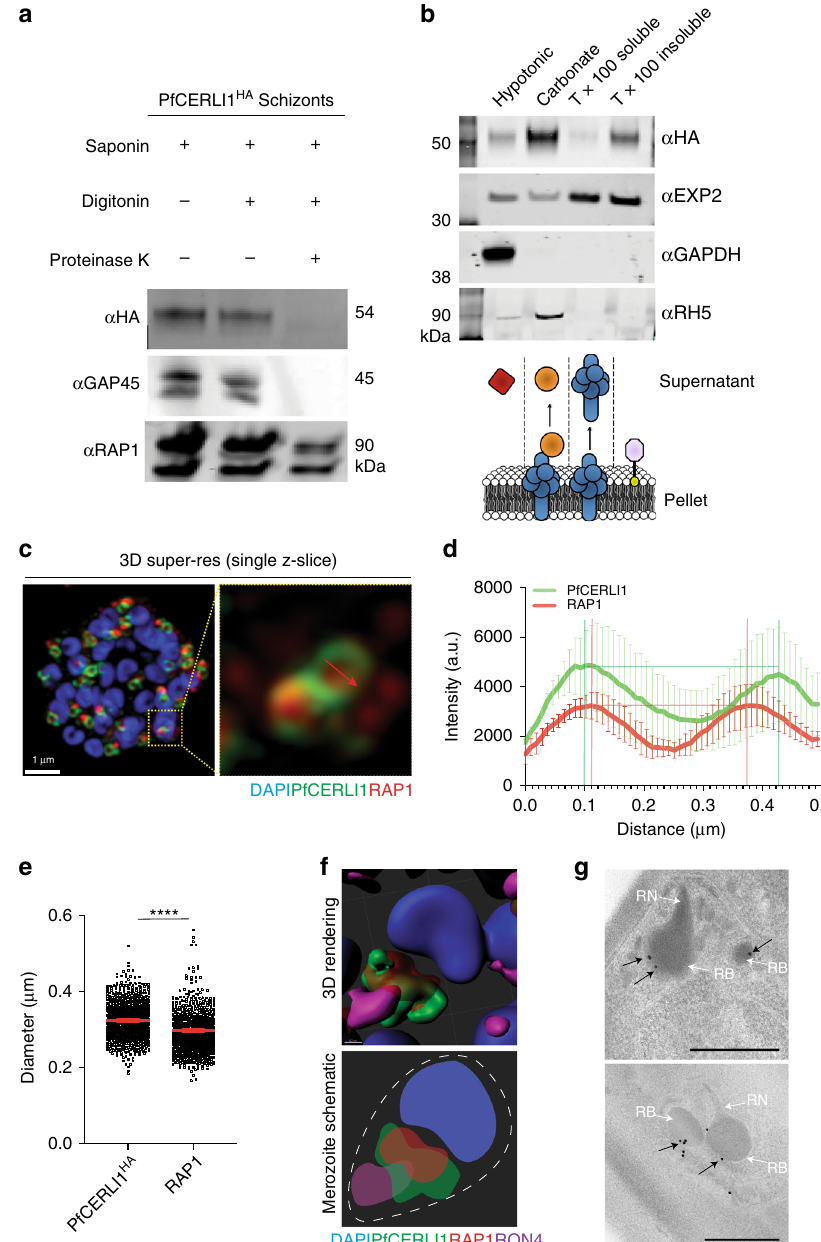
Fig. 4 PfCERLI1 is peripherally-associated with the cytosolic face of the rhoptry membrane. a PfCERLI1 HA schizont cultures were used for a proteinase K protection assay. Parasites were treated with either saponin alone, saponin and digitonin or saponin, digitonin and proteinase K and probed with anti-HA antibodies (PfCERLI1). GAP45 (inner-membrane complex, exposed to the cytosol) and RAP1 (rhoptry lumen) serving as positive and negative controls, respectively, for proteinase K digestion. Selected images representative of three independent experiments. b To determine membrane association, PfCERLI1 HA schizont cultures were subjected to a solubility assay. Saponin lysed parasite cultures were hypotonically lysed before being treated with sodium carbonate and then Triton-X-100 (Tx100), with supernatants and the Tx100 insoluble fraction being reserved after each treatment. Resulting samples were probed with anti-HA antibodies (PfCERLI1). The presence of a strong band in the carbonate treatment indicates release of the majority of PfCERLI1 protein into the supernatant with this treatment. Membranes were also stained with anti-EXP2 (transmembrane domain containing), anti-GAPDH (cytosolic) and anti-RH5 (peripheral) solubility controls. Selected images representative of three independent experiments. c A single z-slice of the double- bulbous rhoptries displaying the scheme that was used to measure the fl uorescence intensity peaks ( d ) and diameter ( e ) of anti-HA and anti-RAP1 staining across the rhoptry (**** p < 0.0001 by unpaired two-tailed t -test, n = 5 biological replicates, 1139 rhoptries measured for PfCERLI1 HA and 1040 for RAP1, Error bars = SEM). f 3D rendered image of a free merozoite showing the nucleus (DAPI) localising at the basal surface, PfCERLI1 (HA) wrapping around RAP1 at the rhoptry bulb and RON4 localising in the rhoptry neck at the far apical tip. g Representative image of Compound 1 treated PfCERLI1 HAGlmS schizonts that were fi xed, labelled with anti-HA antibodies and probed with 18 nm colloidal gold secondary antibodies, before being imaged using transmission electron microscopy. White arrows mark rhoptry bulb (RB) and neck (RN), while black arrows mark PfCERLI1 foci. Scale bar = 500